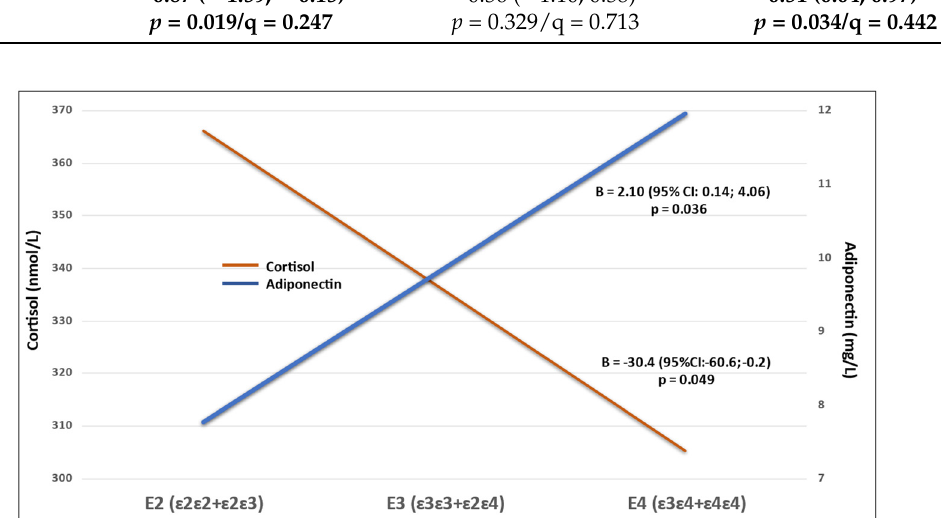
Figure 1. The associations between the ordered APOE groups and cortisol and adiponectin presented as the regression lines adjusted for the mean of age, gender, BMI and point of time.